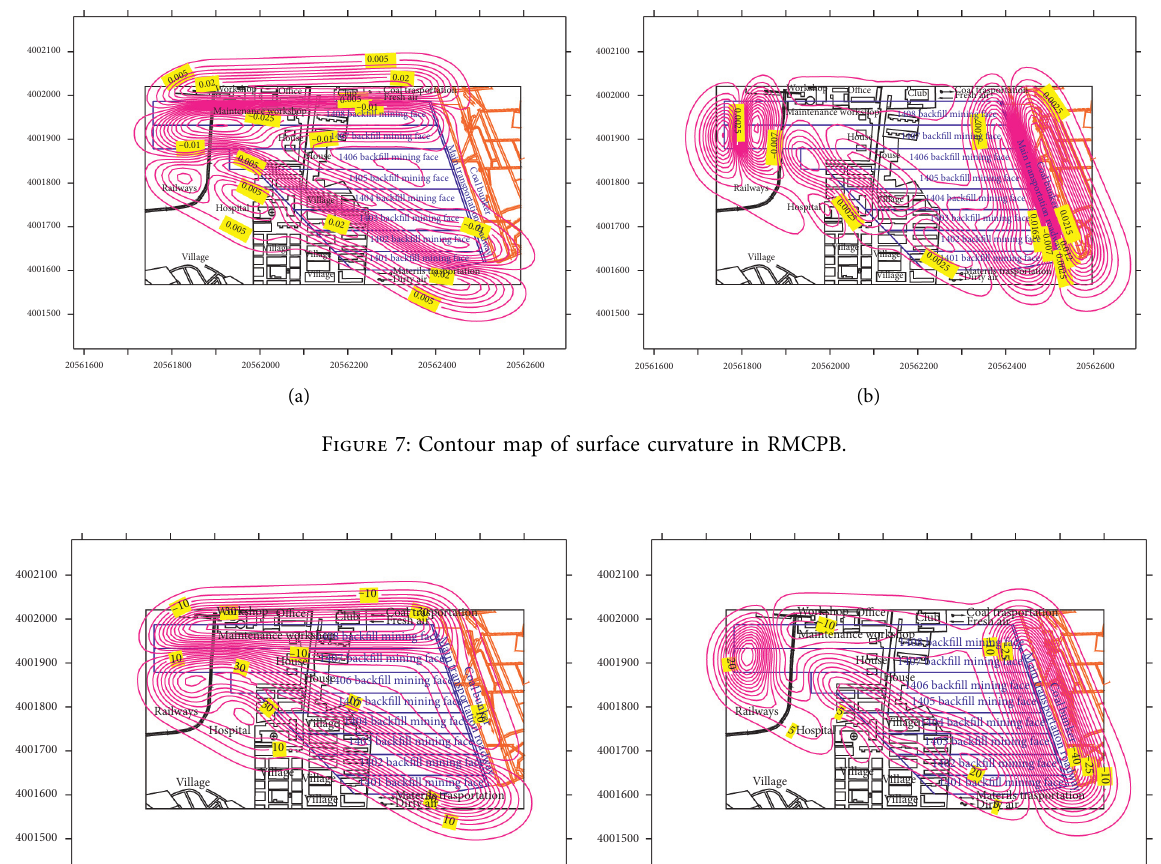
movement of the ground surface along the south-north line was 100 mm and that along the east-west one was 110 mm. the south-north and east-west lines were 0.38 and 0.40 mm/ m, respectively. The maximum inclinations along the south- north and east-west lines were identical and equal to 0.35 mm/m. The maximum curvatures along the south- north and east-west lines were 0.03 and 0.04 mm/m 2 ,